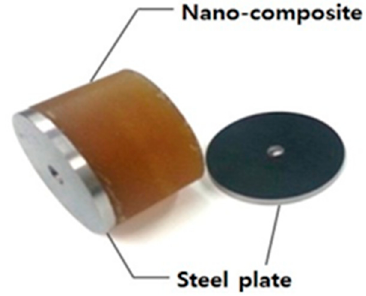
Figure 1. Components of iFLASH system.